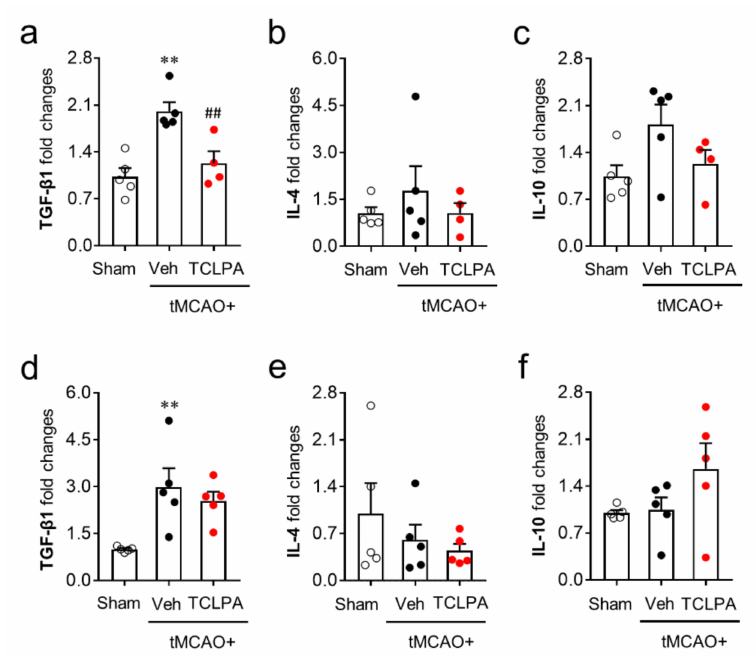
Figure 7. LPA 5 antagonism does not increase mRNA expression levels of anti-inflammatory cytokines in the injured brain after tMCAO challenge. Mice were challenged with tMCAO. TCLPA5 (TCLPA: 10 mg / kg, i.p.) was administered immediately after reperfusion, and mRNA expression levels of anti-inflammatory cytokines (TGF- β 1, IL-4, and IL-10) were determined by qRT-PCR analysis at one ( a – c ) and three days ( d – f ) after tMCAO challenge. n = 4 ~ 5 mice per group. ** p < 0.01 versus sham; ## p < 0.01 versus vehicle-administered tMCAO group.